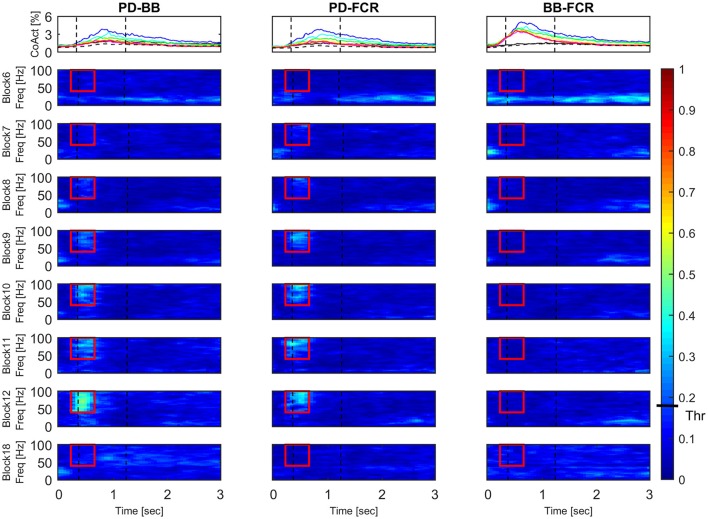
Block-by-block evolution of co-contraction profiles (top panels) and intermuscular coherence statistic maps (lower panels) during motor adaptation for muscle pairs PD-BB, PD-FCR, and BB-FCR. The co-activity of the three pairs of interest is described in terms of co-contraction and IMC across experimental blocks. Co-contraction averaged (N = 16) profiles (top panels) are color-coded from block 6 (baseline, black line), through all motor adaptation blocks (block 7, blue–block 12, red), to block 18 (late wash out, dashed black line). For a complete legend, see Figure 3. IMC is reported as absolute values in all blocks. Dashed black vertical lines represent averaged movement onset and movement offset in each block according to kinematic measures. This figure demonstrates that during motor adaptation there is a decrease of co-contraction during adaptation (Block 7–12) in some of the muscle pairs (PD-BB, PD-FCR) accompanied by an increase of high-frequency IMC. On the other hand, there is a constant increase in co-contraction during adaptation (Block 7–12, BB-FCR) with no significant IMC patterns. The confidence interval is represented by a black bar on color scale (Thr)–all colors above bar are significantly different from zero.